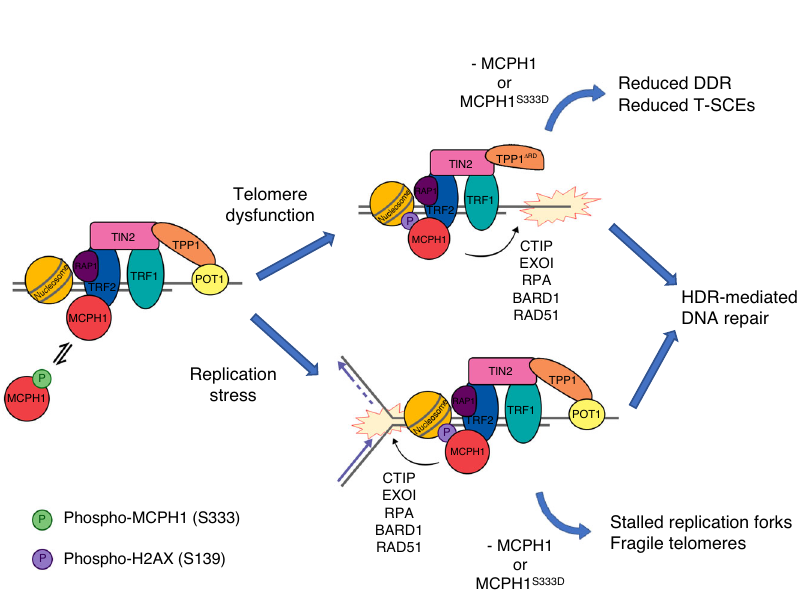
(Fig. 5g, h), facilitating fork progression through telomeric repeats. In the absence of MCPH1, replication stress at telomeres likely results in increased replication fork stalling and the acti- vation of an ATR-dependent DDR that can lead to either cellular senescence or apoptosis. The sensitivity of MCPH1-de fi cient cell lines to PARP inhibition and to HU treatment has clinical implications for the treatment of tumors harboring MCPH1 mutations. Olaparib has been successfully used to treat BRCA1- de fi cient tumors since the combined effects of PARP inhibition